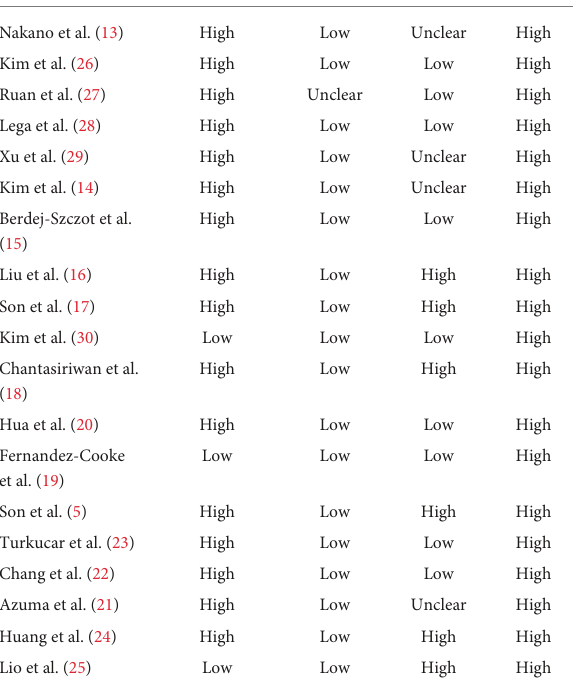
TABLE 1 Risk of bias assessment (using PROBAST) based on four domains across 27 studies that created CALs prediction models for Kawasaki